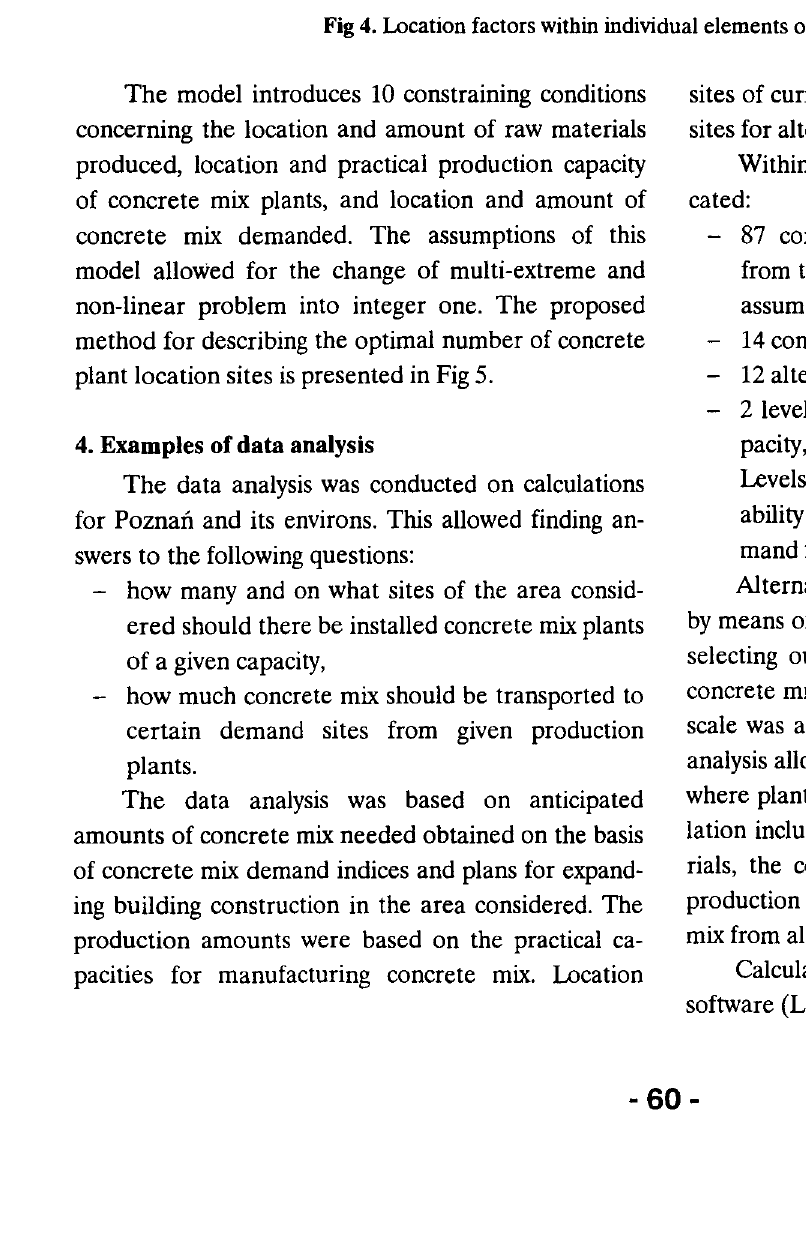
Fig 4. Location factors within individual elements of a production